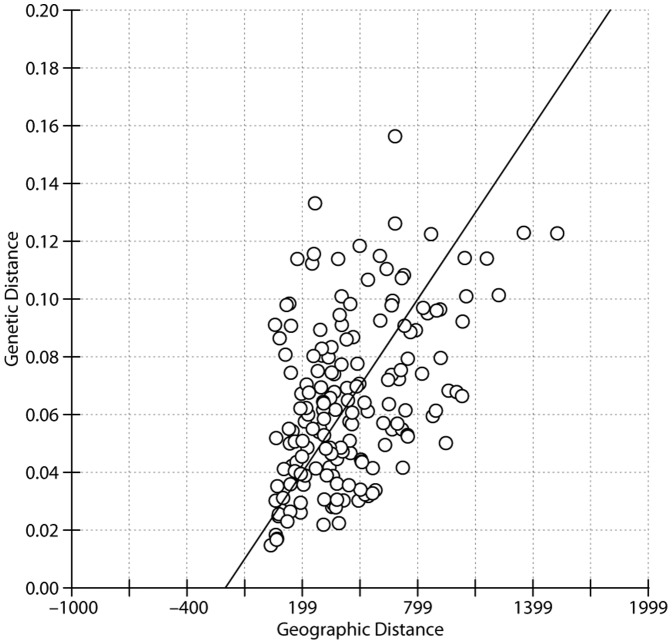
Correlation between genetic distance and geographic distance for Siberian apricot populations.Genetic distance is represented by pairwise FST/(1–FST) estimates among populations, which is regressed against the geographic distance. The RMA regression line overlays the scatterplot.